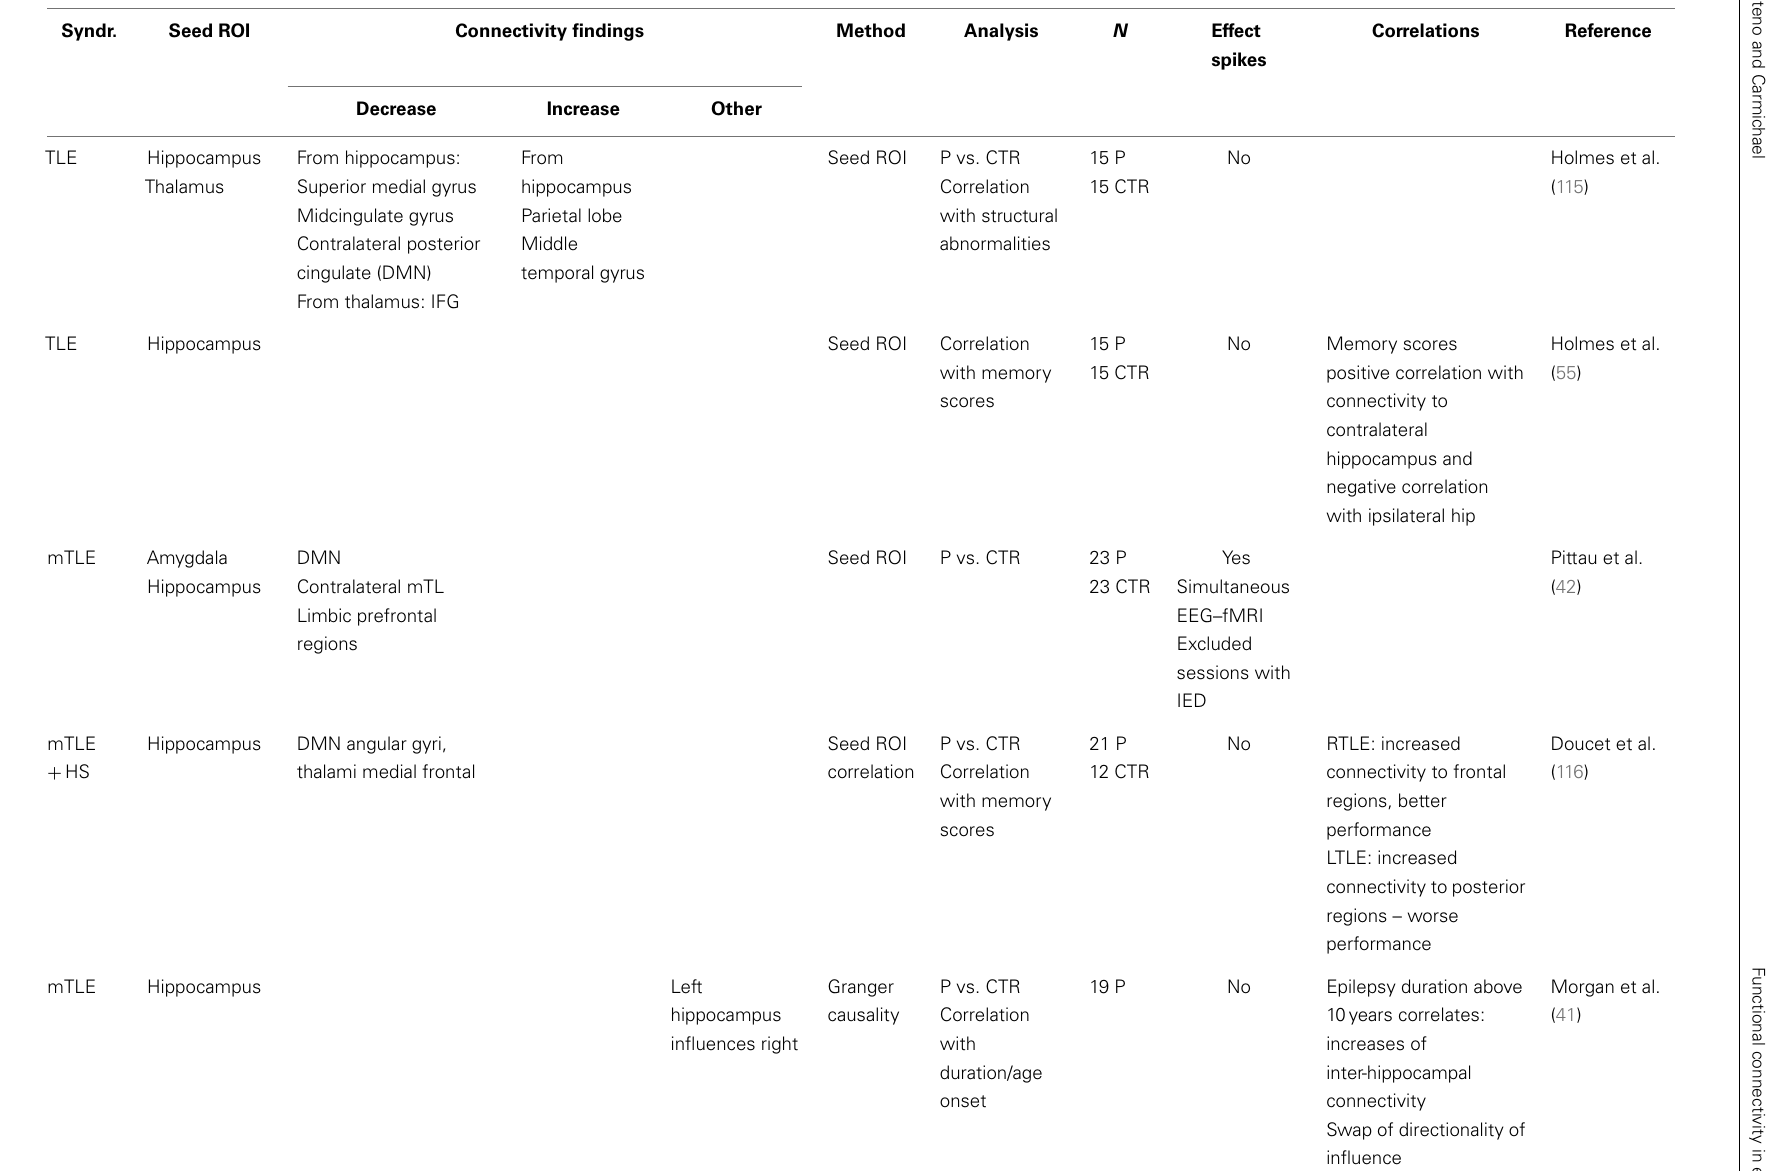
Table 1 | Resting state studies in epilepsy reporting abnormalities of the epileptogenic network .